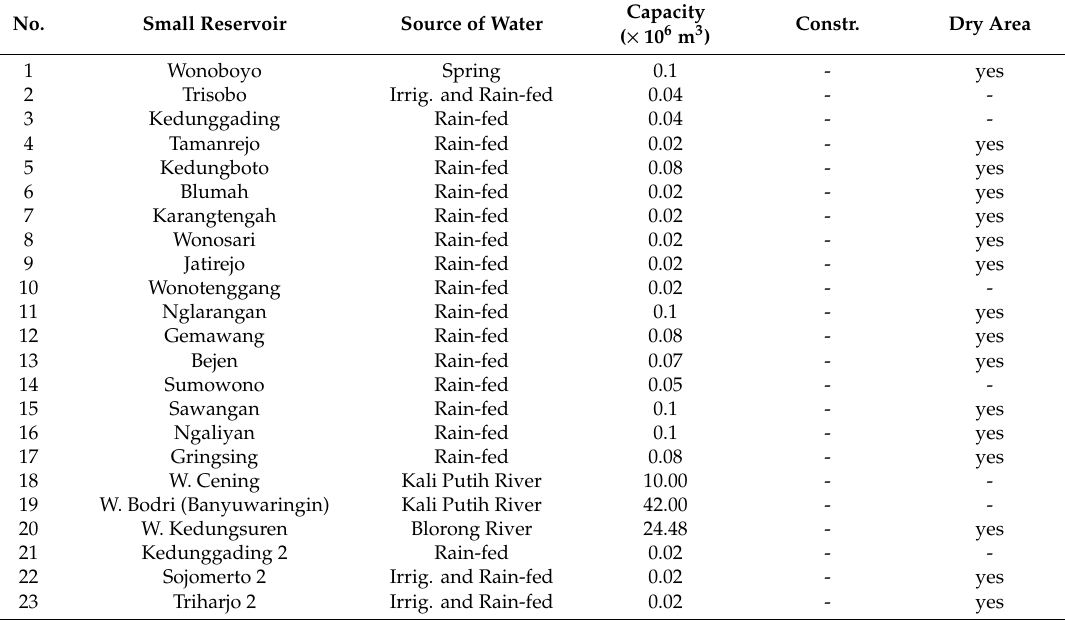
Table 2. On-going small reservoir developments (under construction or